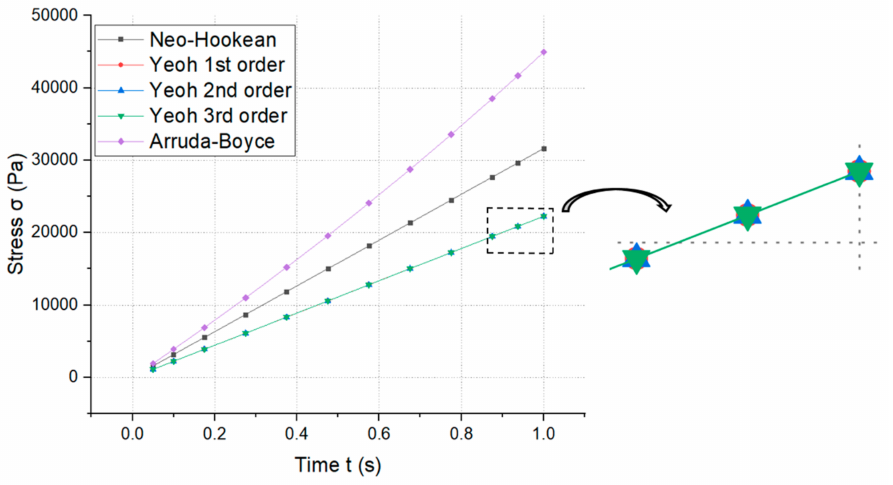
Figure 11. Variation in stress according to crack time in the hyperelastic material models.